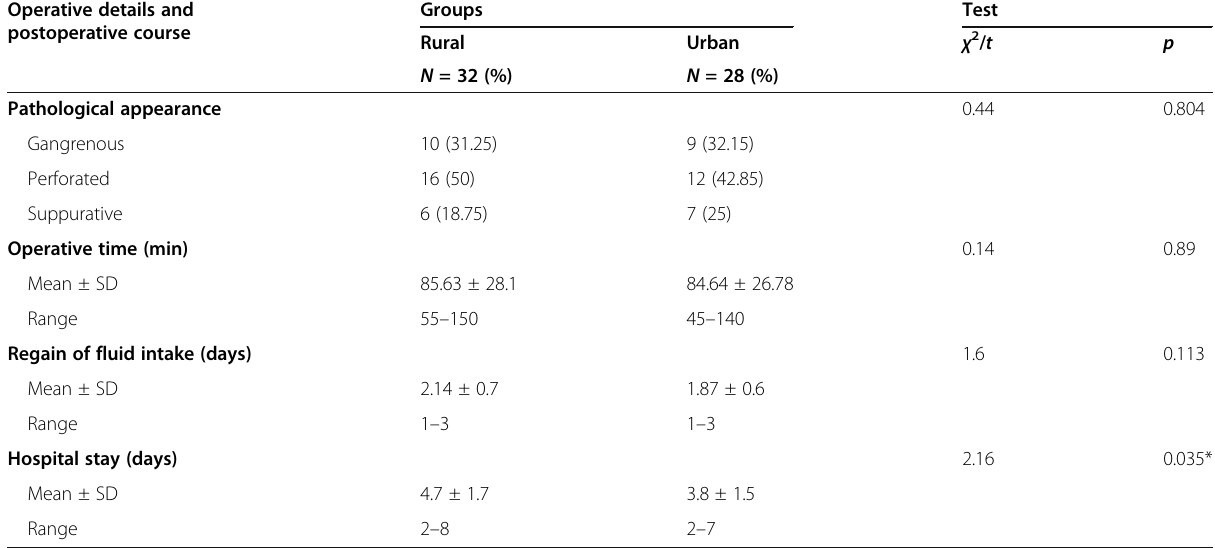
Table 2 Operative details and postoperative course Operative details and postoperative